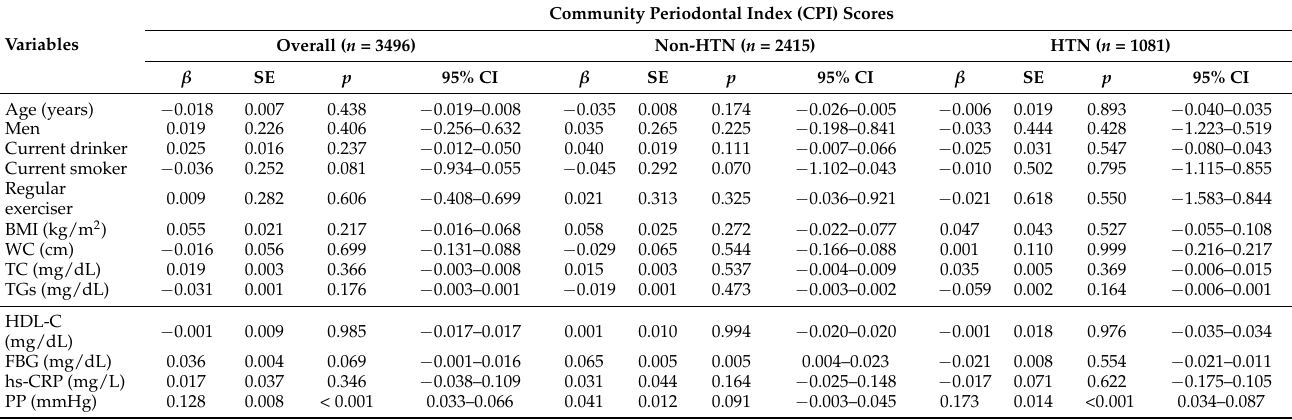
Table 3. Linear regression analysis of independent factors determining community periodontal index scores.